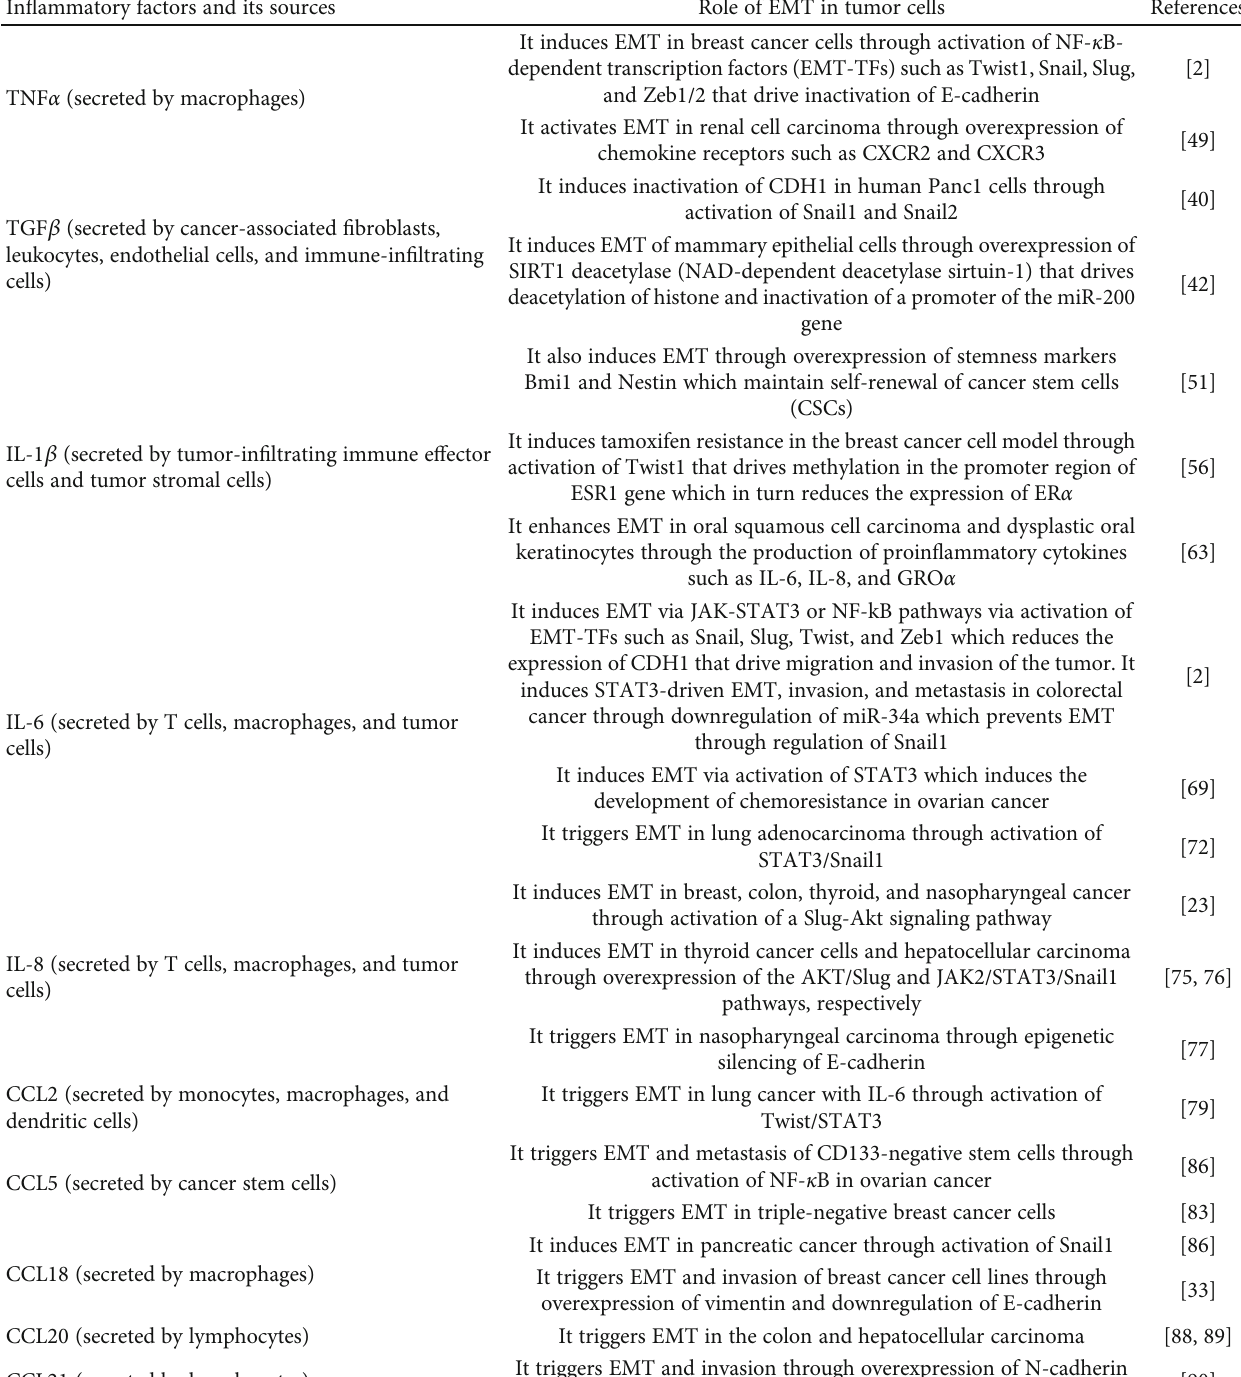
Table 1: Role of in fl ammatory proteins in regulation of EMT in tumor